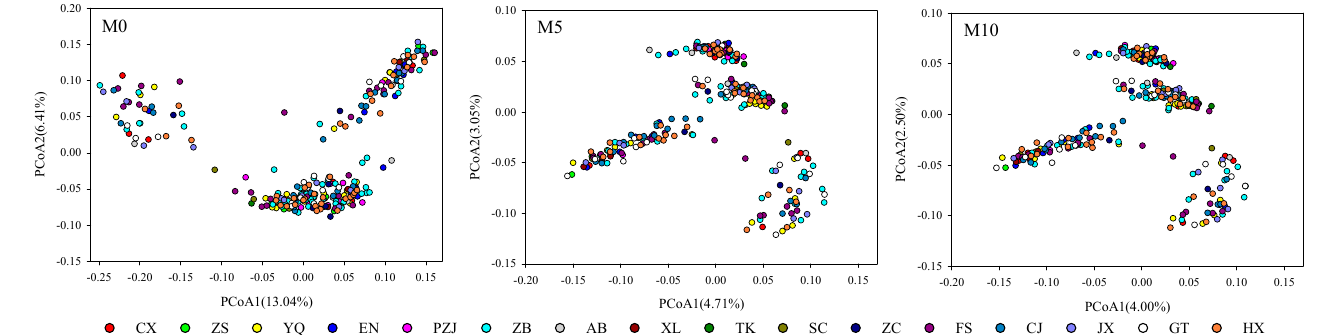
Figure 3. PCoA plots of 299 Masson pine samples based on the SNPs with different missing levels of M0, M5, and M10. The different signals of colored circles with the related abbreviations represent the original resource of subpopulations from four local populations displayed in Table S1.